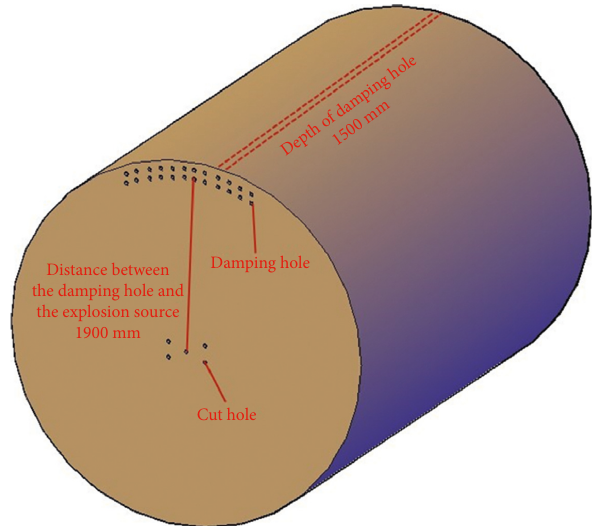
Figure 4: General arrangement of vibration damping